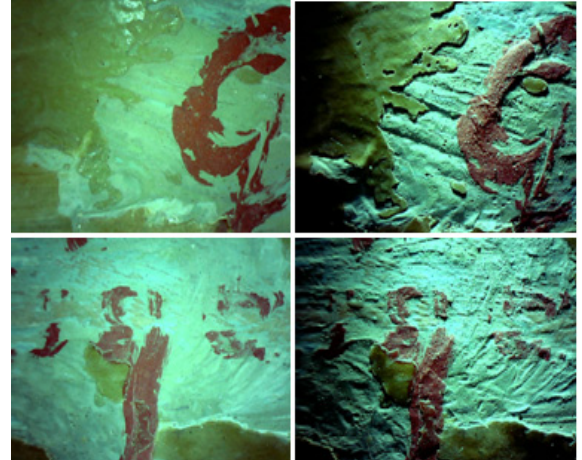
Figure 7. Areas with signature characters, in visible and white-green light dynamically reflected from two analysis areas.